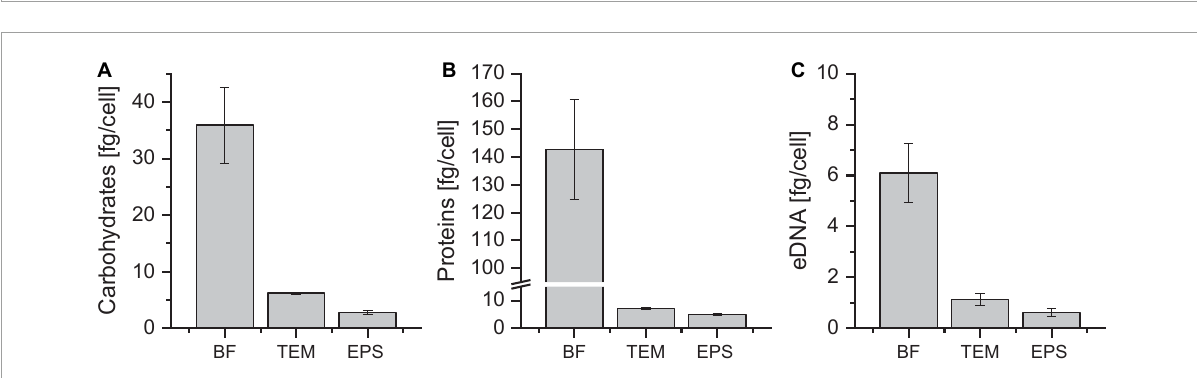
FIGURE2 Amounts of carbohydrates (A) , proteins (B) , and eDNA (C) in different Sulfolobus acidocaldarius MW001 biofilm fractions. Biofilms were grown on hydrophilic PTFE membranes at 76 ◦ C for 4 days (liquid Brock medium, pH 3.0, 0.1% ( w/v ) NZA, 0.2% ( w/v ) glucose, 10 µ g/mL uracil).